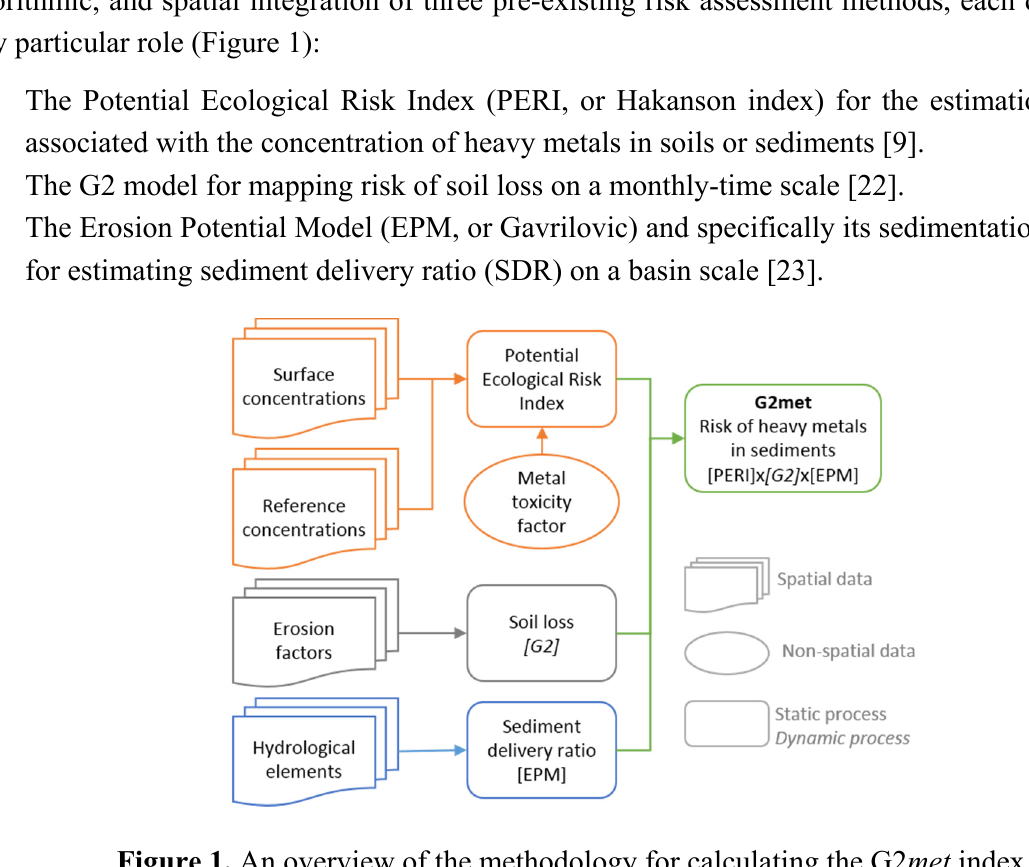
Figure 1. An overview of the methodology for calculating the G2 met